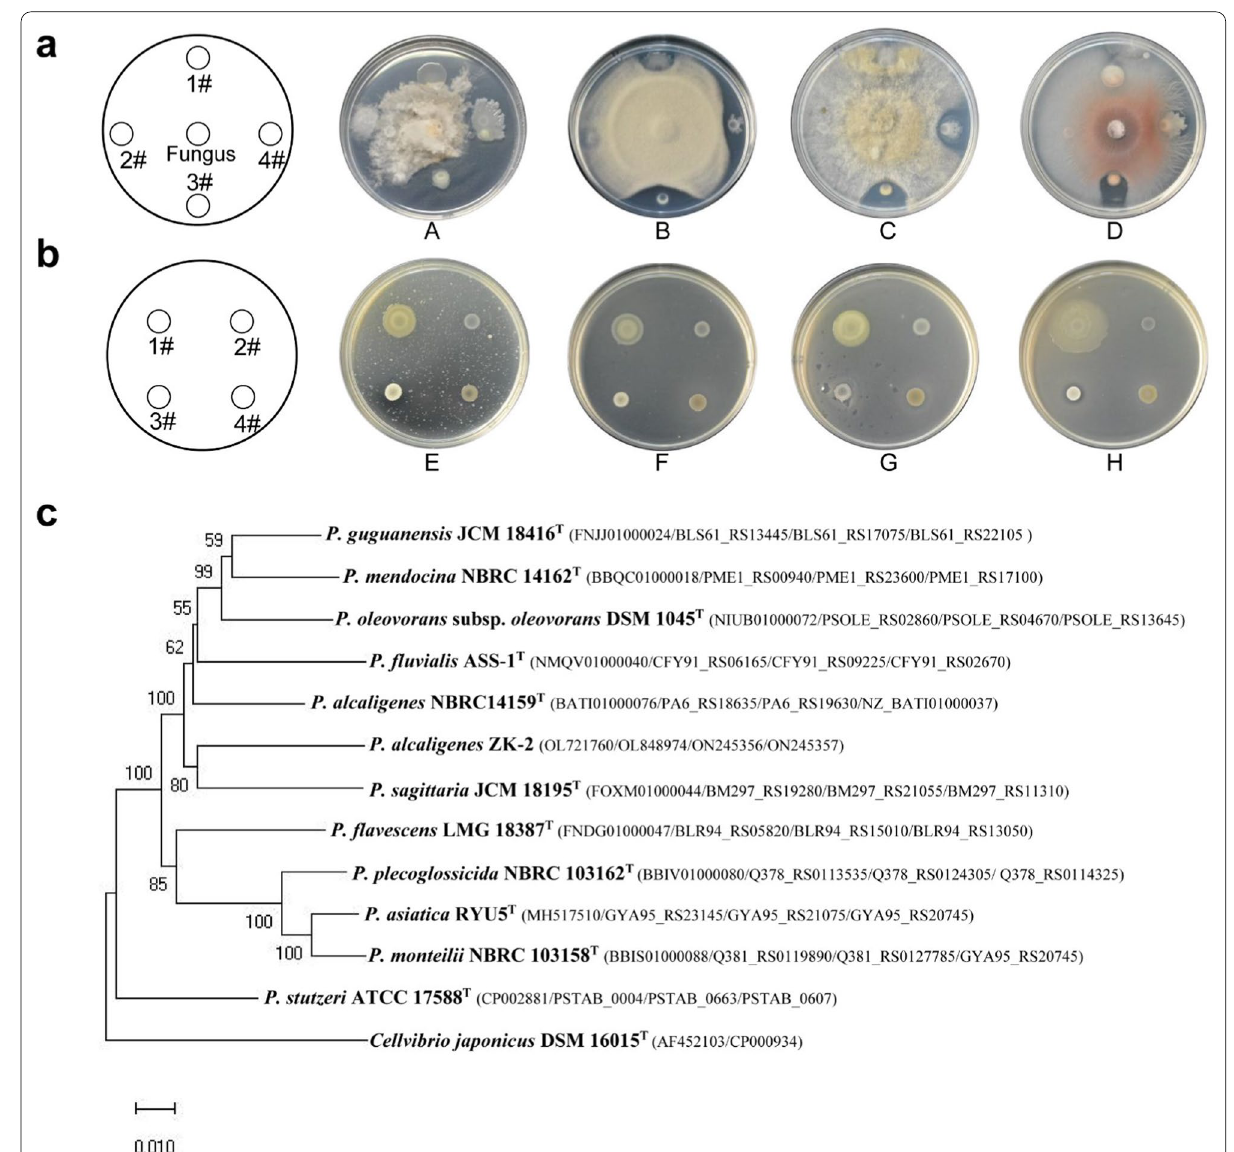
Fig. 3 Isolation of antifungal Pseudomonas alcaligenes ZK-2 from turfgrass seeds by mono-enrichment of the pathogenic fungus